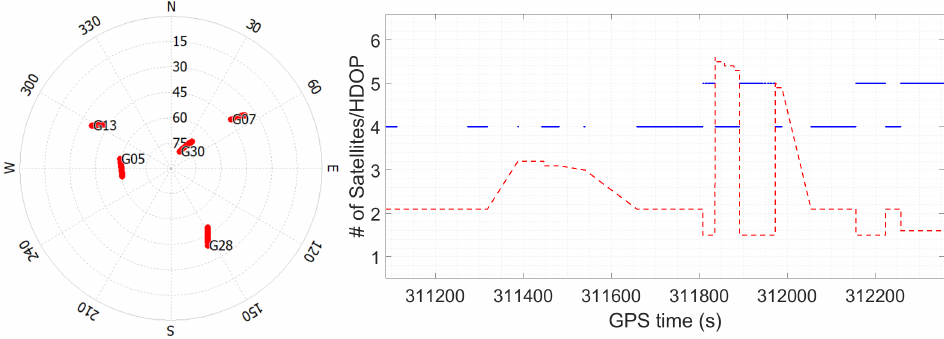
Figure 5. Skyplot and HDOP for test 1 (steering